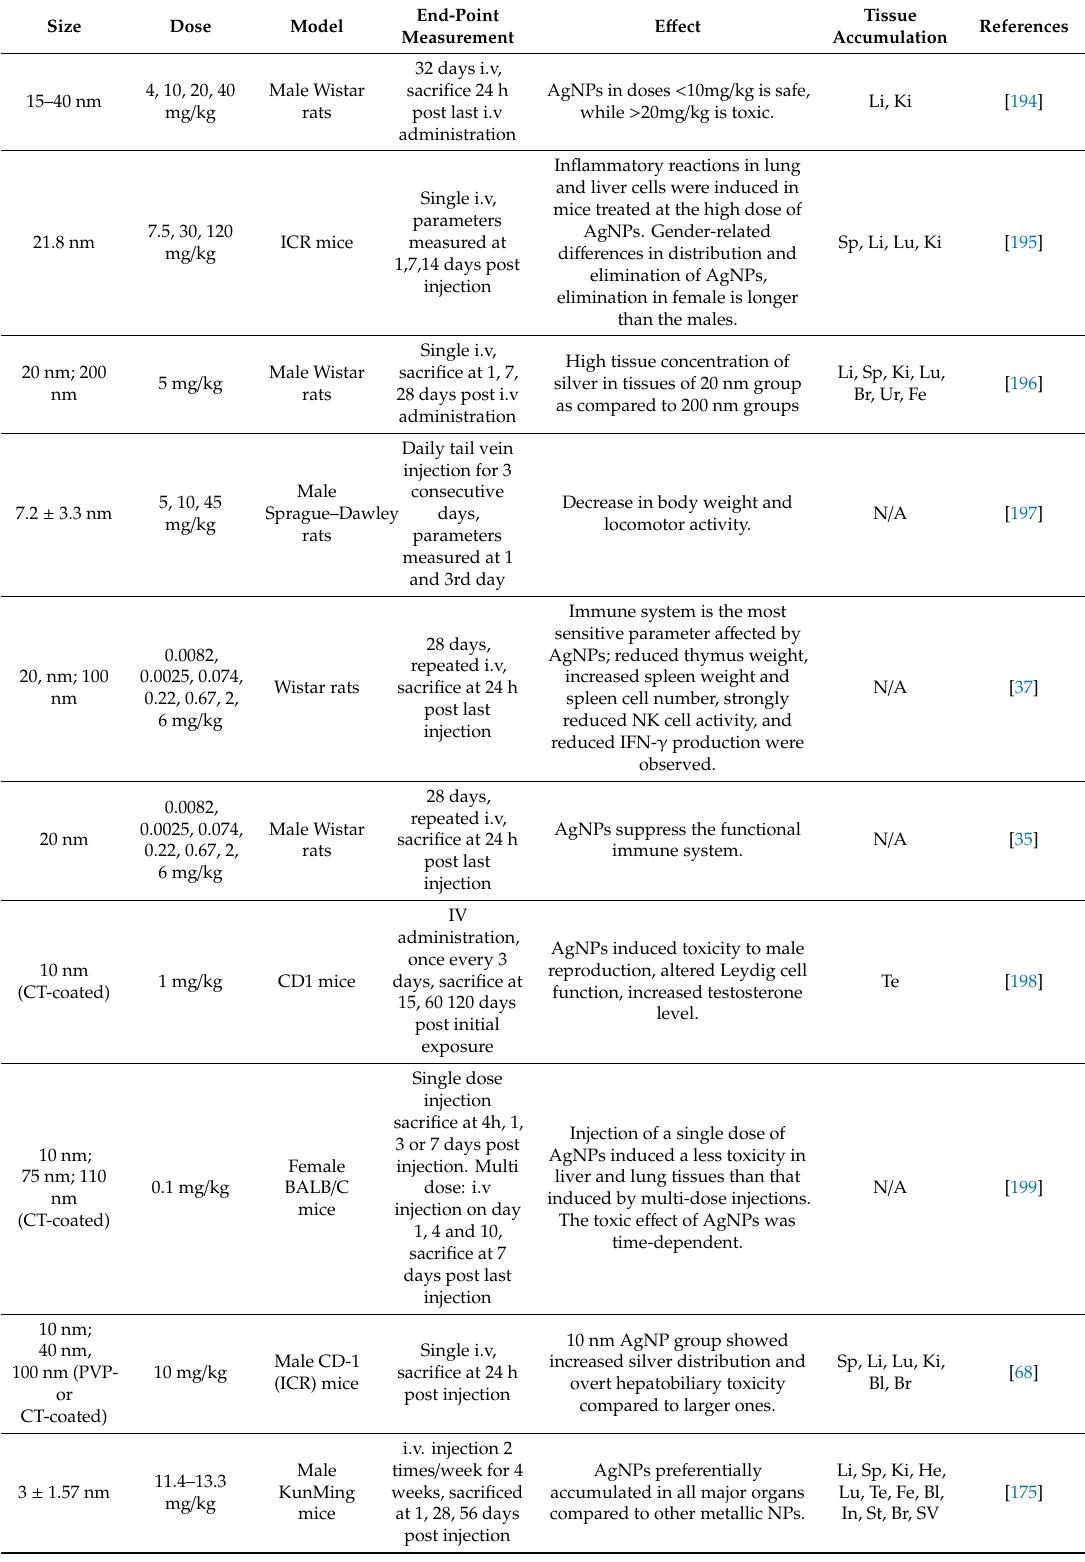
Table 4. Toxicity and biodistribution of AgNPs in rodents via exposure through intravenous